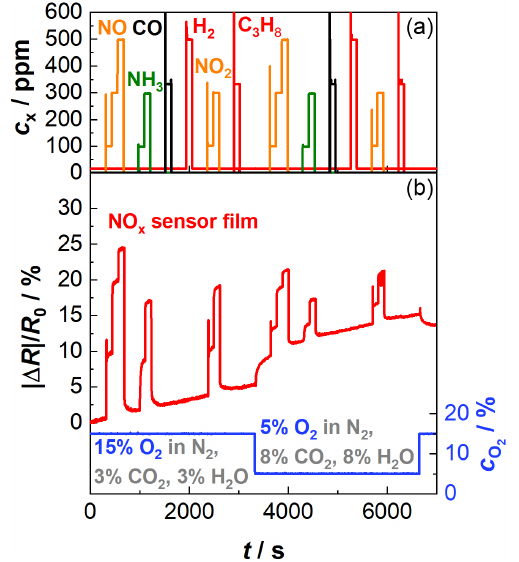
Figure 2. Sensor test procedure (a) and response of the NO x sensor film (b) to NO, NH 3 , CO, H 2 , NO 2 , and C 3 H 8 ; sensor temperature: 650 ◦ C; composition 1: 15% O 2 , 3% CO 2 , 3% H 2 O balanced by N 2 until 3700s; composition 2: 5% O 2 , 8% CO 2 , 8% H 2 O bal- anced by N 2 after